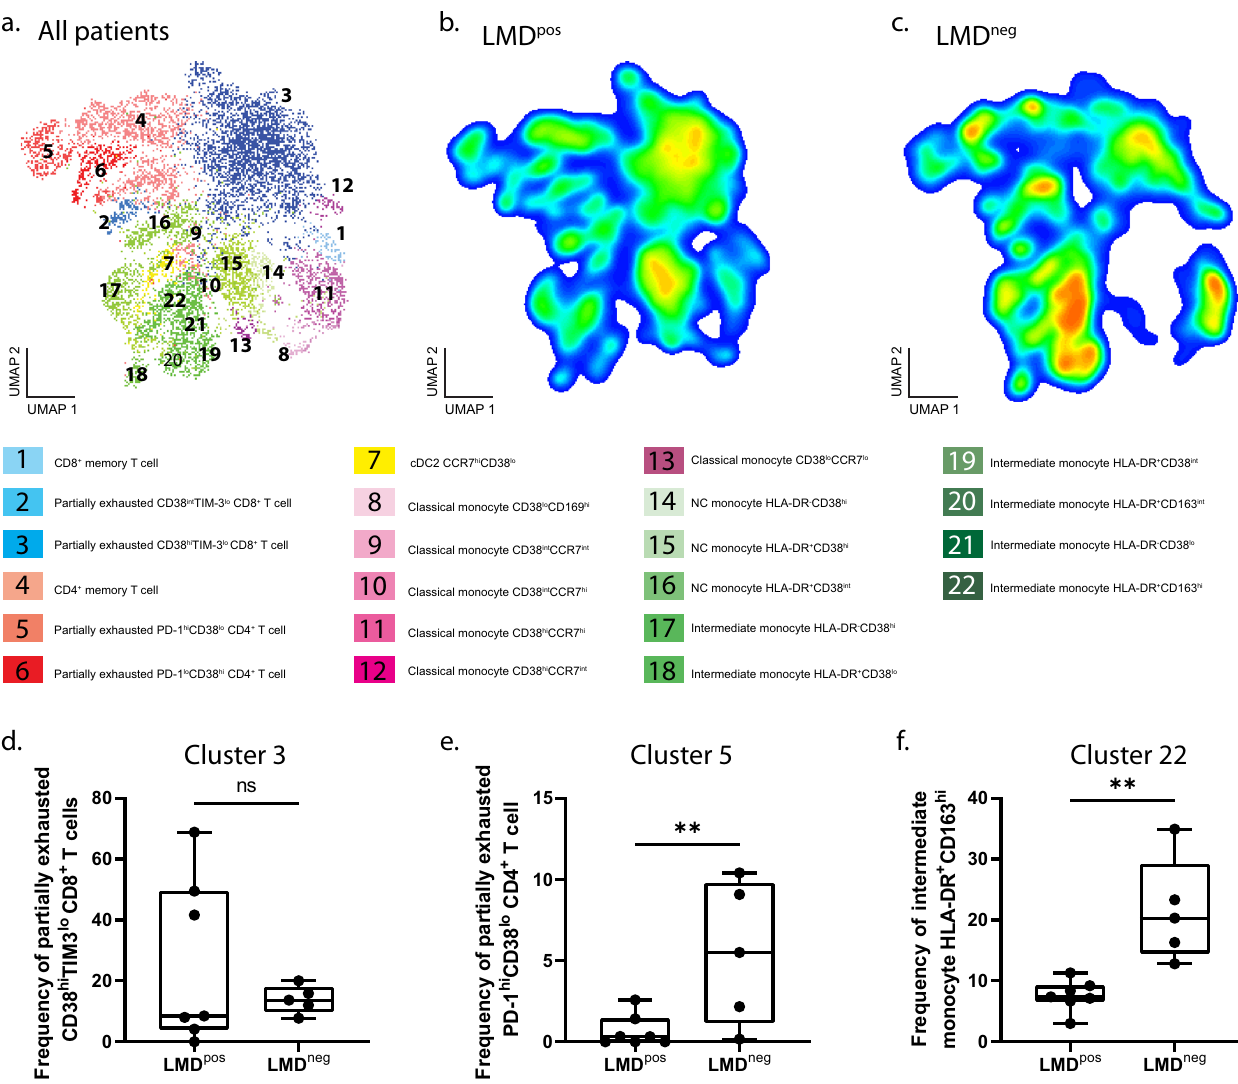
Fig. 5 Unsupervised immune pro fi ling in PBMCs reveals unique subsets of CD4 + T cell and monocyte populations. a UMAP projection of annotated clusters from all patients. b , c Density heat maps of immune cells in patients with LMD (LMD pos ) ( b ) and patients without LMD (LMD neg ) ( c ), with red representing the most prevalent cell types and blue representing the least prevalent cell types. d Frequency box plots of cluster 3, partially exhausted CD8 + T cell (CD38 hi TIM3 lo ), e cluster 5, partially exhausted CD4 + T cell (PD-1 hi CD38 lo ), and f cluster 22, intermediate monocytes expressing HLA-DR and CD163 out of the 22 identi fi ed cluster populations. For box plots in this fi gure, the boxes indicate the interquartile range, while the lower and upper bars correspond to the minimum and maximum non-outlier values of the data distribution. Centerline indicates the median value. Statistical signi fi cance was assessed in d – f by one-way ANOVA followed by the Tukey post hoc test. (* or **) indicates statistical signi fi cance with p < 0.05. n.s not signi fi